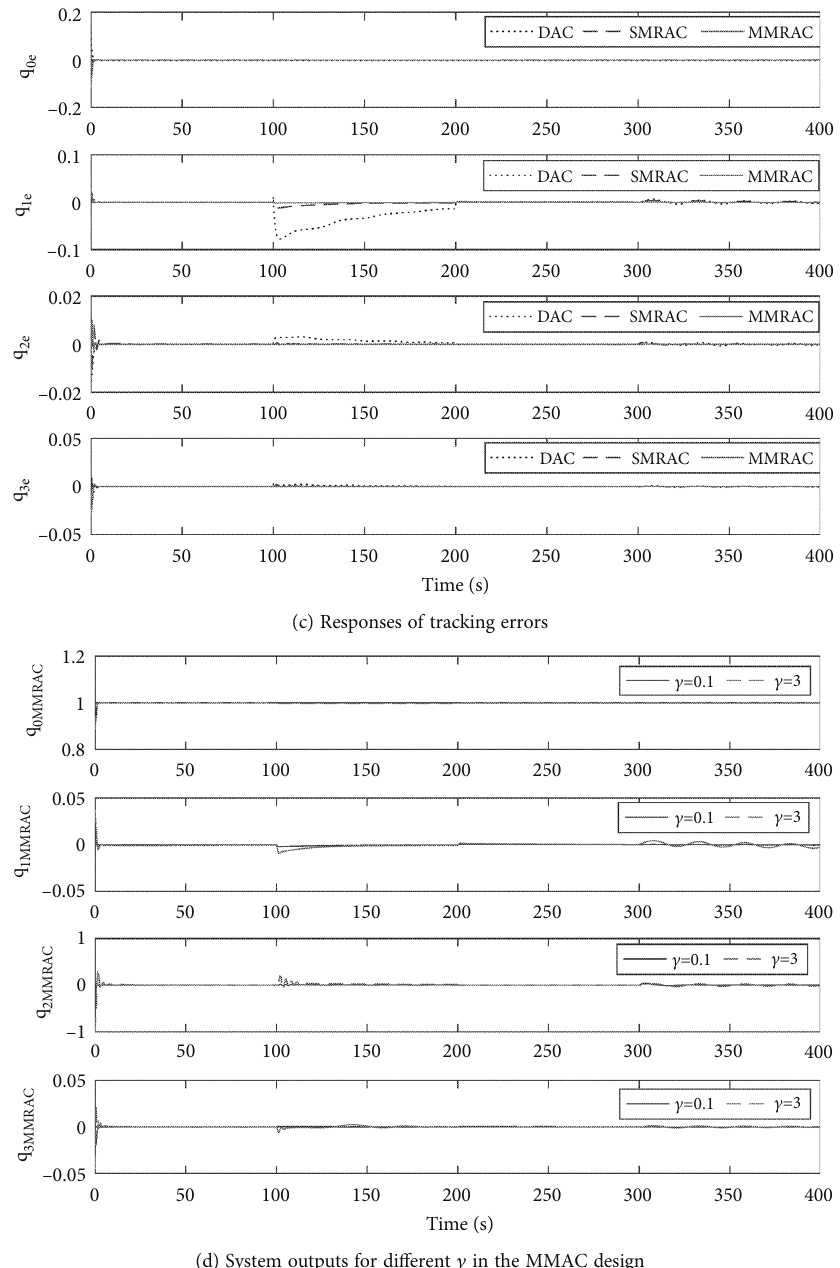
Figure 3: Attitude tracking control using MMRAC-, SMRAC-, and DAC-based fault-tolerant control schemes for Case